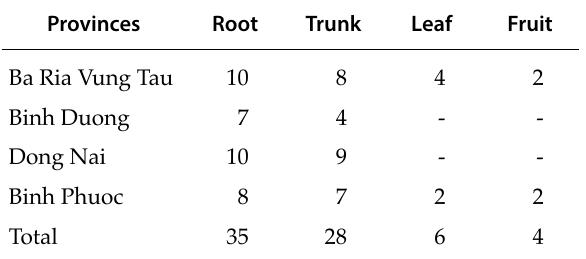
Table 1. Origin of Phytophthora palmivora isolates obtained in four provinces of South Vietnam from jackfruit trees with symptoms of decline, and number of plantings where they were